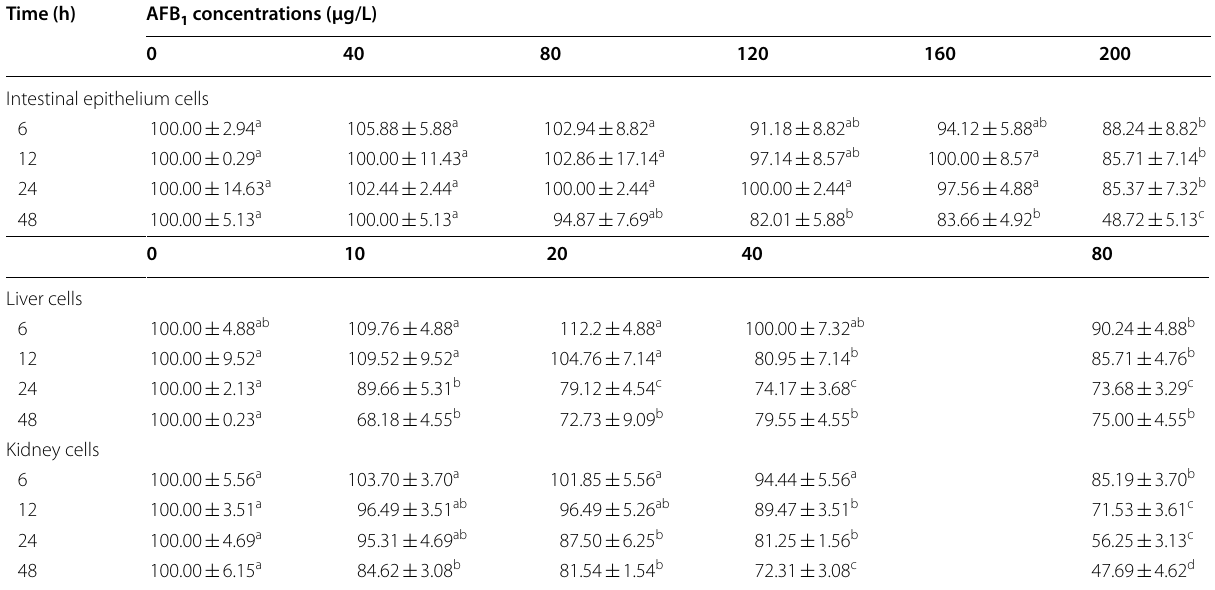
Data were expressed as mean SD (n 8). The different lowercase letters in the same row indicate significant difference from each other ( p < 0.05), while the same ± = lowercase letters in the same row indicate insignificant difference from each other ( p > 0.05)